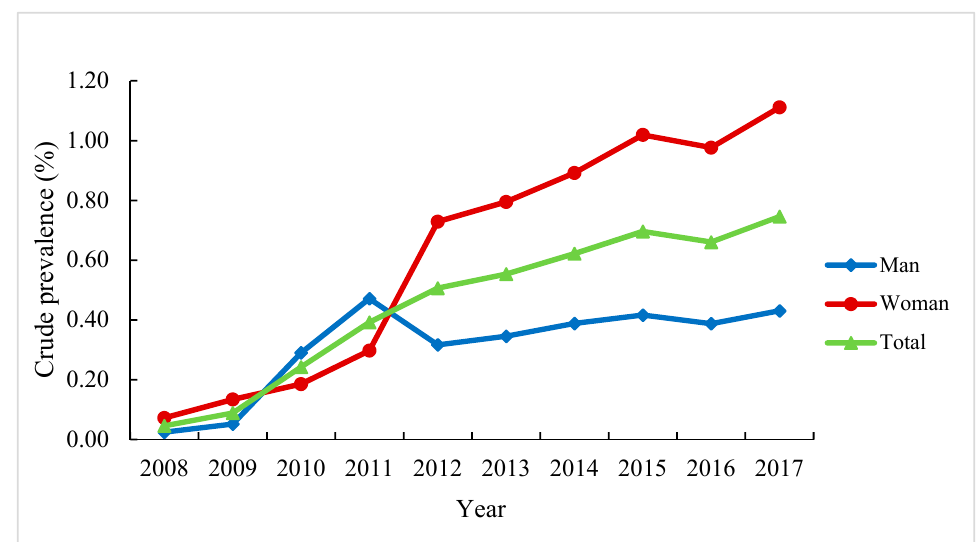
Figure 2. Annual crude prevalence of knee osteoarthritis in people under 35 years old in Beijing from 2008 to 2017 (%).